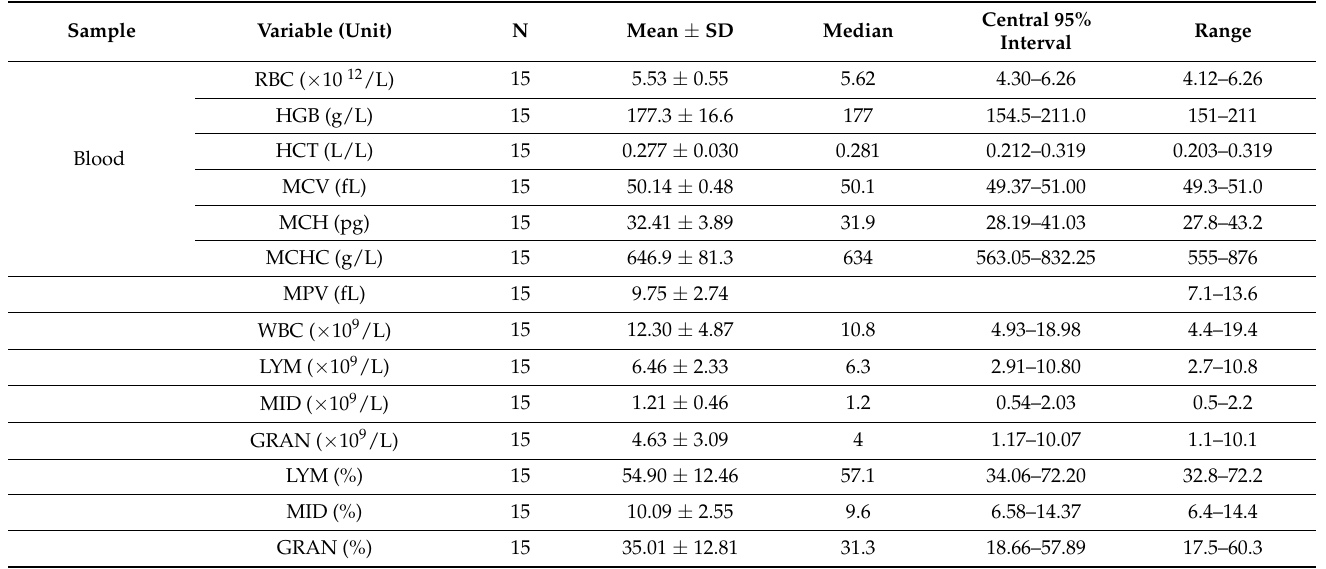
Table 4. Hematological and serum chemistry data of the captured Apennine